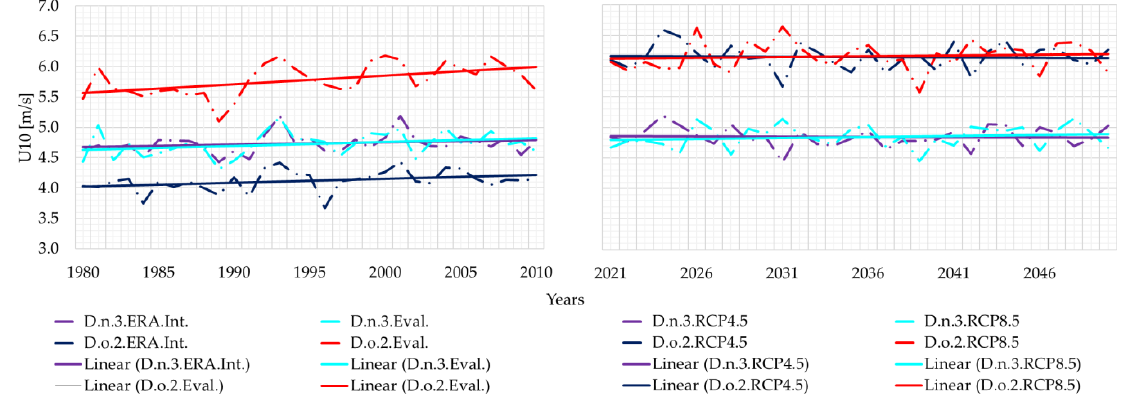
Figure A1. Annual averages of the wind speed at 10 m height for two of the most representative points located in shallow water (D.n.3) and in deep water (D.o.2) of Russia. ERA.Int and Eval data, time interval 1981–2010, RCP4.5 and RCP8.5 data, time interval 2021–2050.